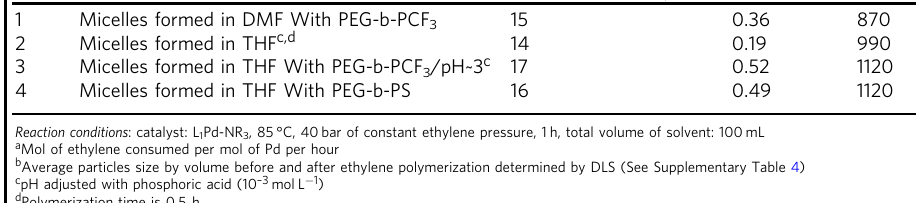
Table 4 Variation in reaction conditions Entry Reaction changes